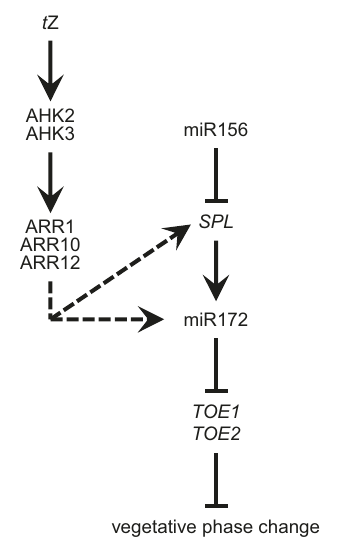
Fig. 7 Model of the cytokinin-dependent regulation of vegetative phase change. The CK receptors AHK2 and AHK3 as well as the type-B response regulators ARR1, ARR10, and ARR12 are activated mainly by t Z. Activation of CK signaling in the shoot results in an increase of miR172 abundance. MiRNA activation may be achieved directly by type-B ARRs or involve co- action of SPLs. TOE1 and TOE2 are repressed posttranscriptionally upon miR172 increment, enabling the transition from the juvenile to the adult vegetative